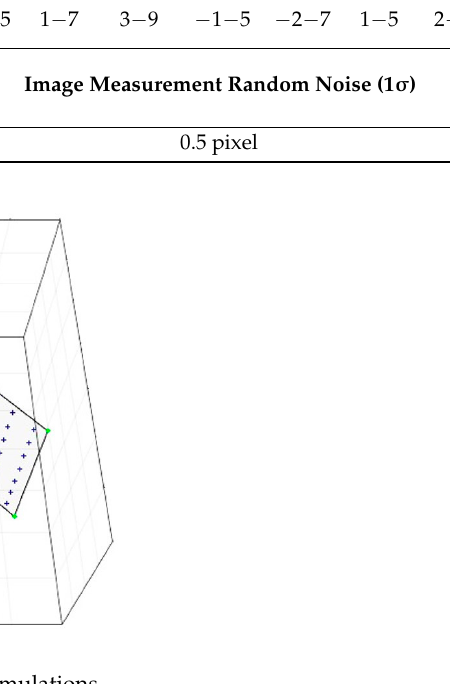
Figure 3. Configuration of image acquisition for simulations.